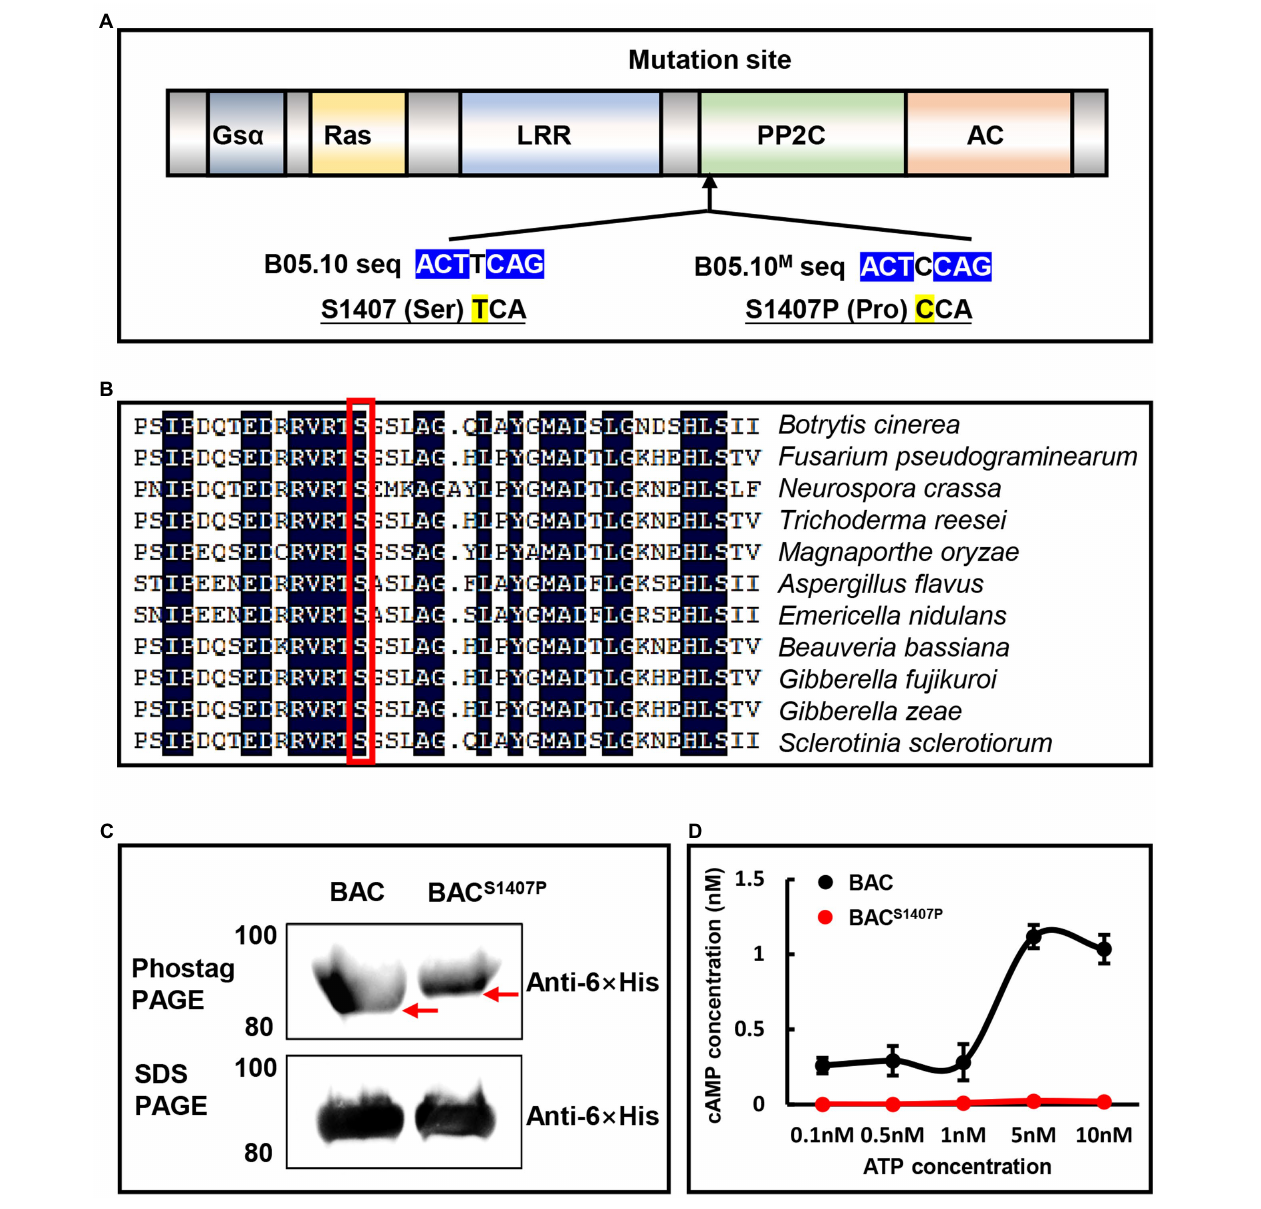
FIGURE 2 (A) Botrytis cinerea adenylate cyclase (BAC) domains analyzed using InterPro and SMART. (B) Conservation analysis of the S1407 locus of BAC. (C) The phosphorylation of BAC-His 6 and BAC S1407P -His 6 was detected by a mobility shift on a Phos-tag SDS–PAGE gel. Red arrows represent different positions of migration (migration direction from bottom to top). (D) Concentration curve of cAMP synthesized by BAC-His 6 PP2C and AC domains and BAC S1407P -His 6 PP2C and AC domains under different concentrations of